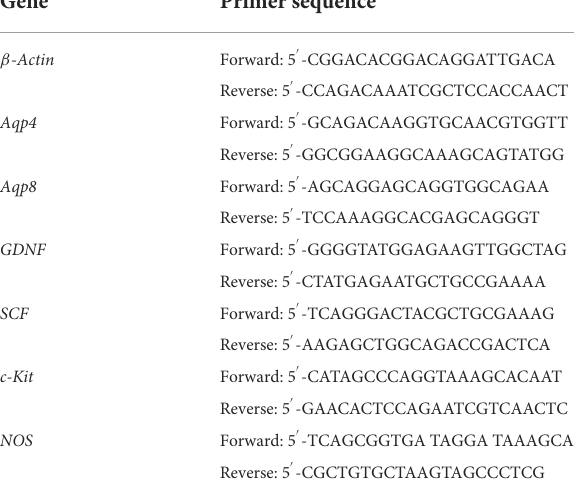
TABLE 1 List of primers used in the qRT-PCR assay for constipation-related intestinal factors. Gene Primer